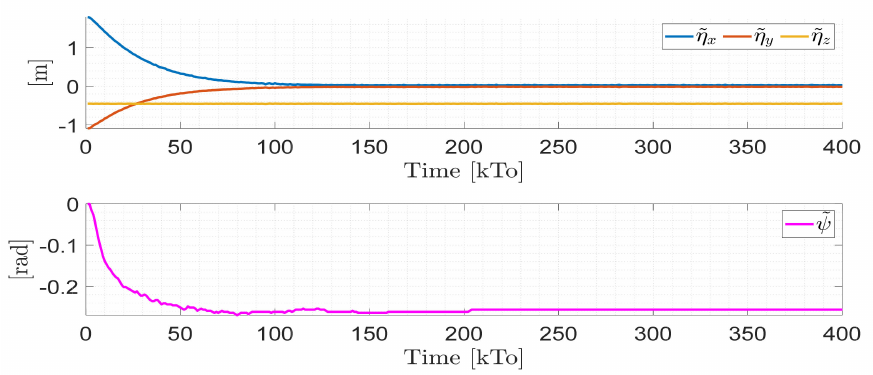
Figure 13. Time evolution of the control errors ˜ η ( kT 0 ) = ( ˜ η x , ˜ η y , ˜ η z , ˜ ψ )